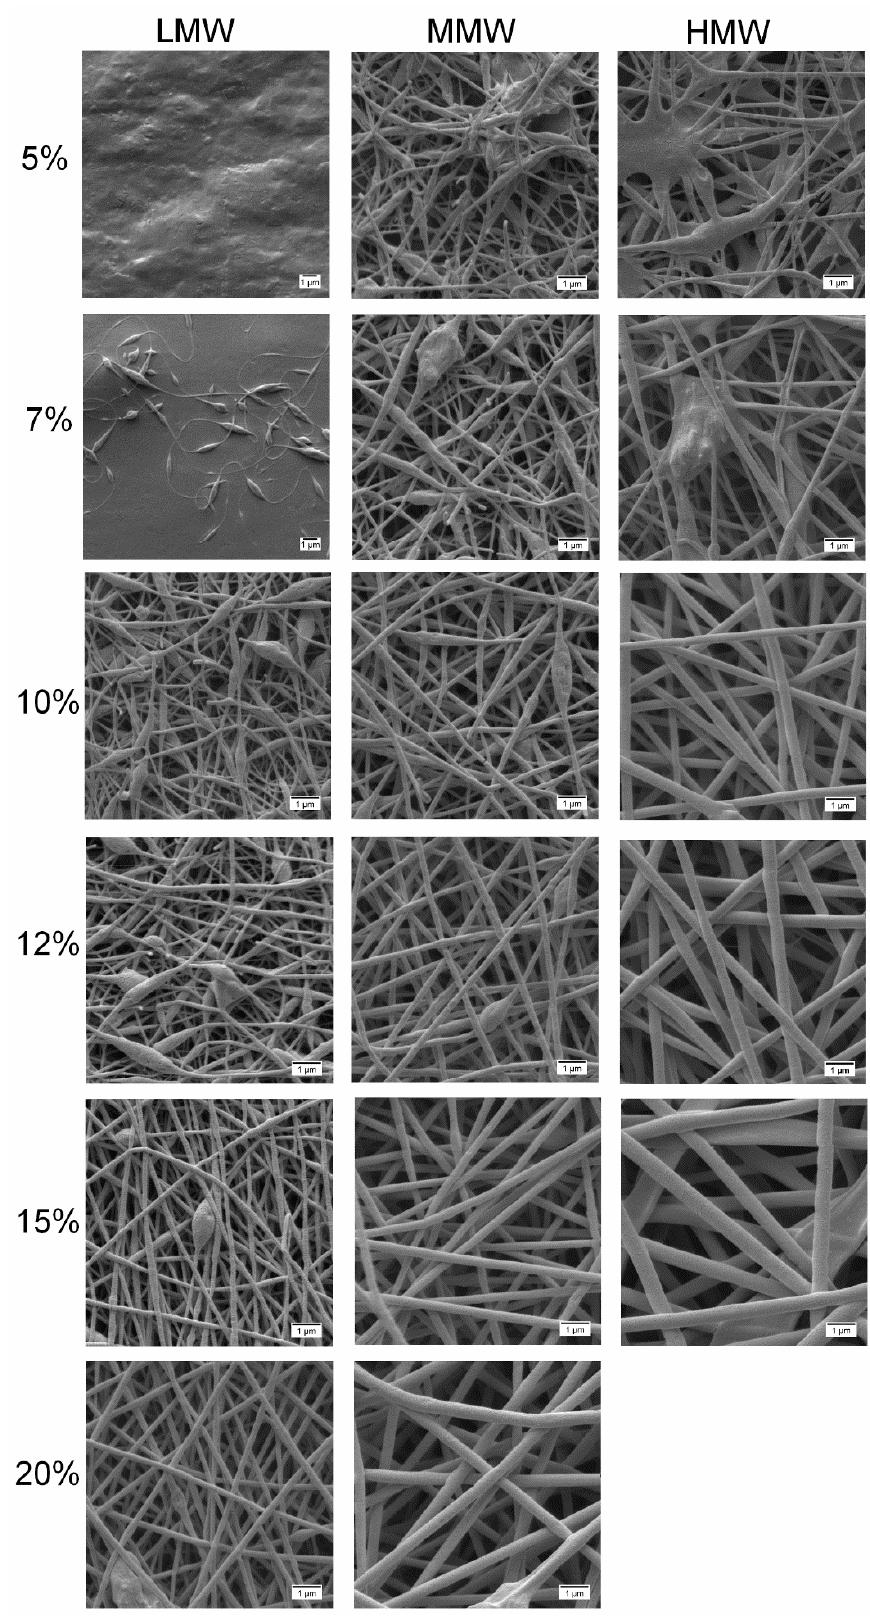
Figure 6. SEM morphologies at 10,000× of loaded electrospun PVA/TE blend (60:40) fibers at different concentrations and molecular weights. All scale bars represent 1 µm.